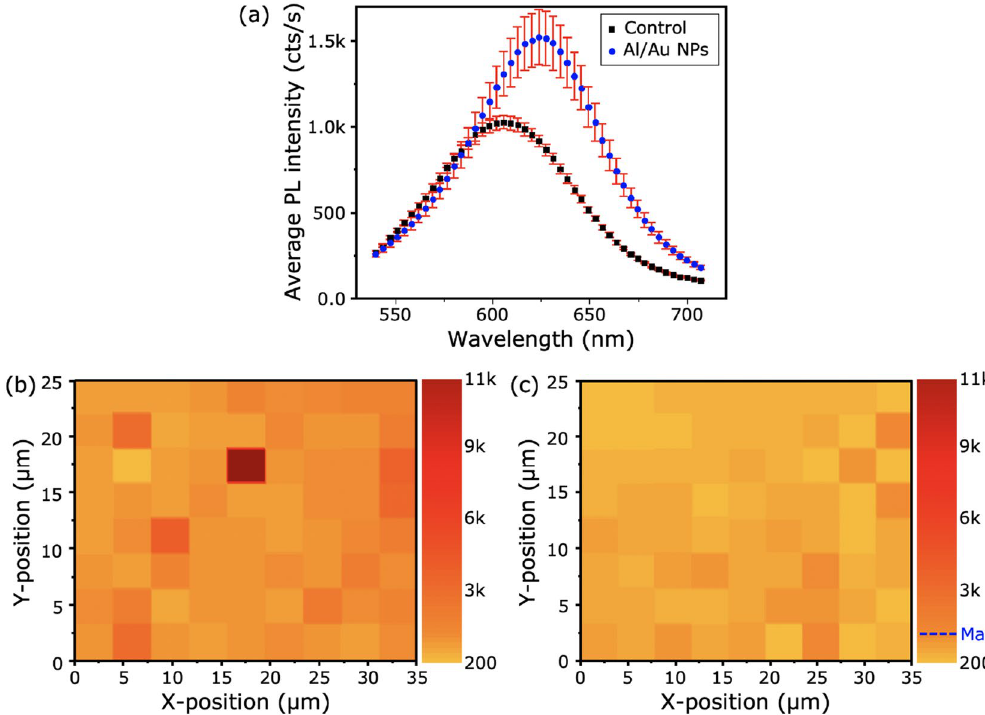
Figure 4. ( a ) Average PL measurements for control (A) and plasmonic nanostructure (B) samples were performed in a marked scanning area (A1 and B1). PL mapping intensity distribution of the plasmonic structure ( b ) and the control ( c ) samples at same location from where the PL measurements were taken with the colour scale representing PL peak